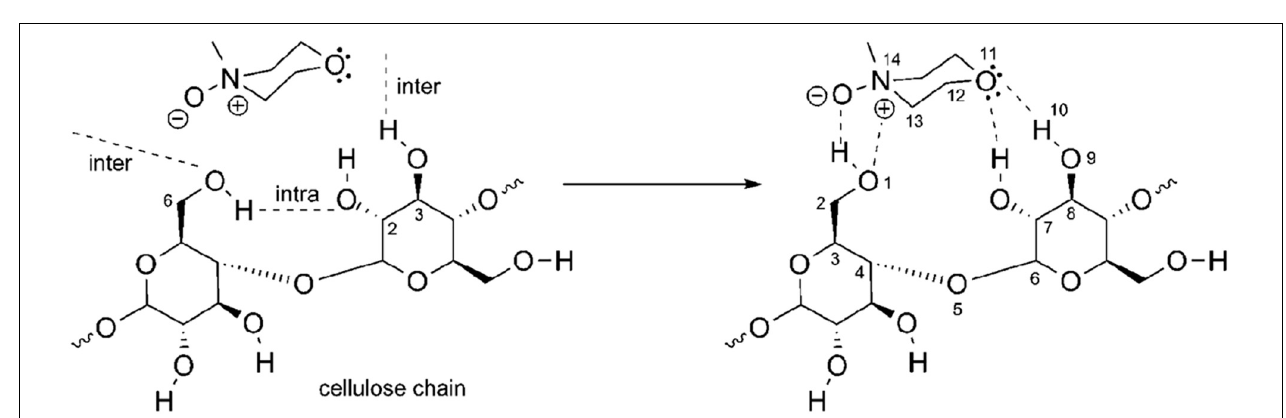
FIGURE 5 | Schematics of Viscose fiber production [addapted from Alagirusamy and Das (2015), Sayyed et al. (2019)].